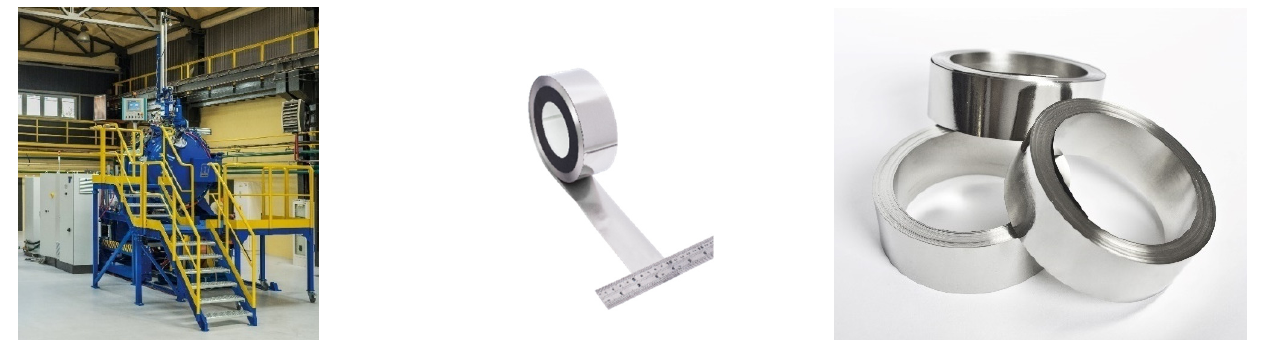
Figure 1. Melt spinning casting setup used in the research, 50.8 mm wide ribbon obtained during the casting, exemplary wound cores prepared for annealing.